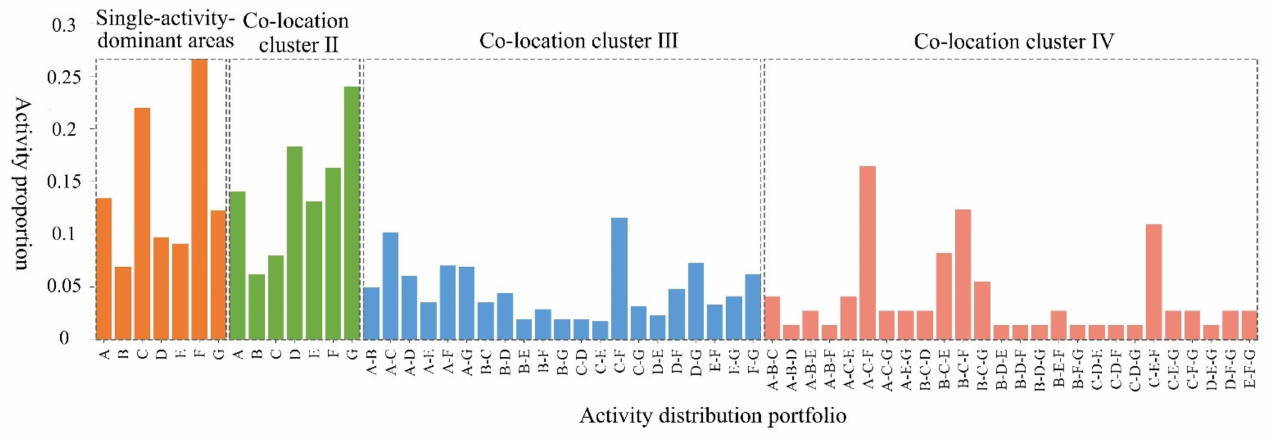
Figure 8. The activity combination portfolio and proportions within different co-location clusters (A: social; B: eating; C: entertainment; D: shopping; E: studying; F: sports; G: working).